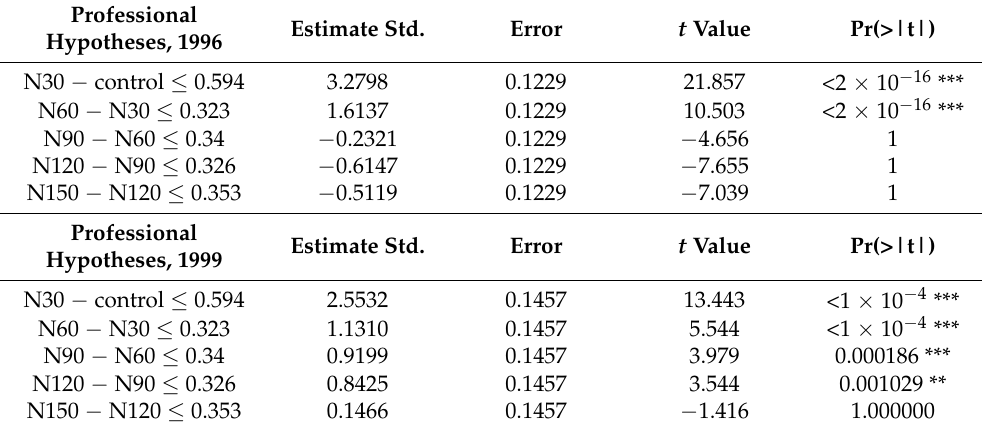
Table 4. Result of the simultaneous tests for general linear hypotheses in two different crop